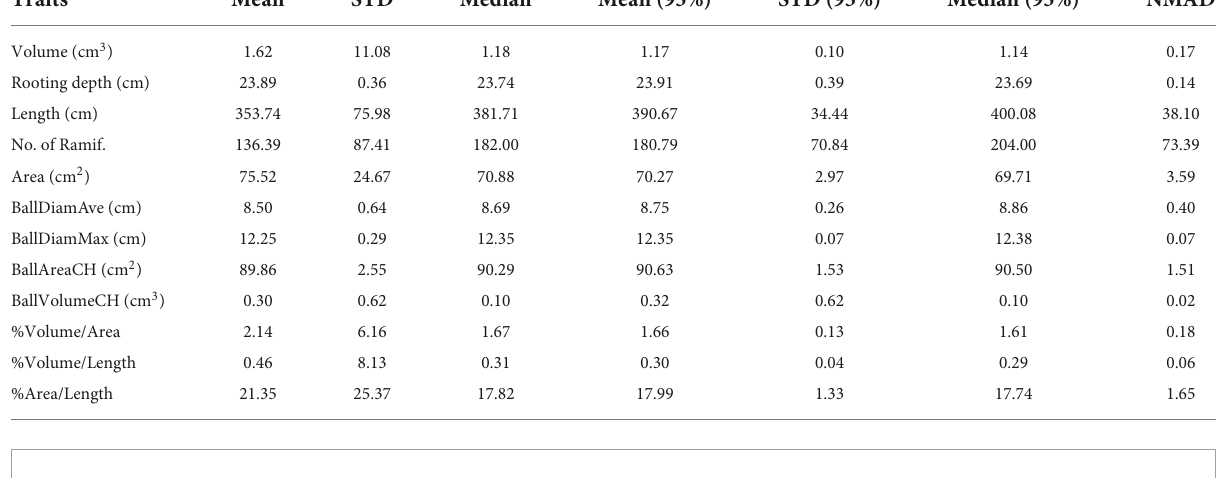
TABLE 3 Statistics of different traits calculated from an SF range from 0.01 to 0.18 [mean, standard deviation (STD), median, mean, and confidence interval (95% CI), STD (95% CI), median (95% CI), and normalized median absolute deviation (NMAD)]. Traits